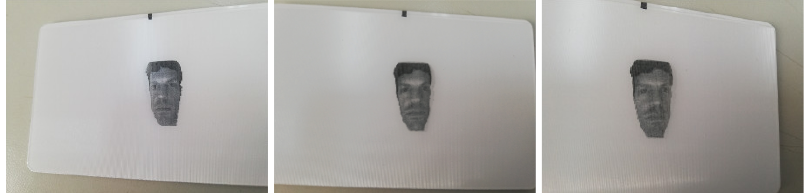
Figure 25. Imprinted lenticular card